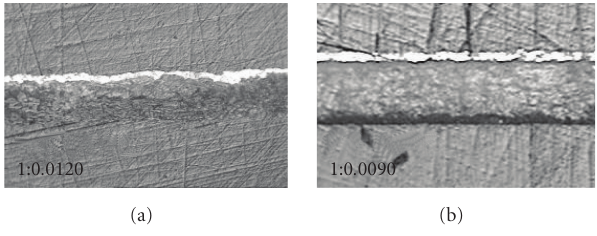
Figure 2: Ink A (a) on paper 1 and (b) on paper 3.